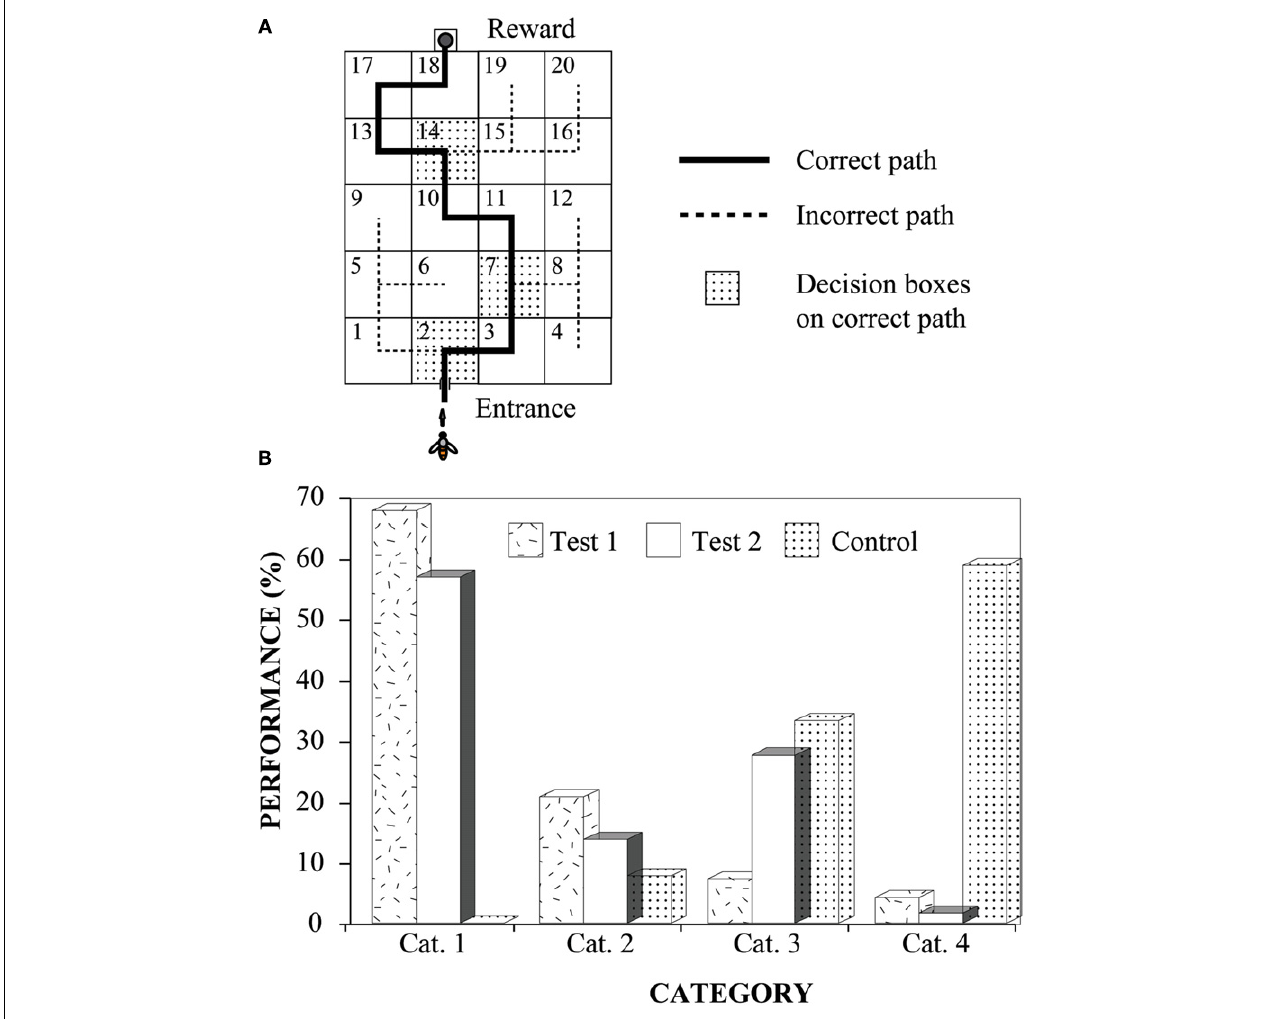
back and retraced her path (once or many times) but remained on the correct path; Cat. 3: flights in which a bee made one or more wrong turns at the decision boxes, but still arrived at the goal within 5min; Cat. 4: unsuccessful searches, defined as flights in which the bee did not reach the goal within 5min of entering the maze (regardless of whether she was on the correct path or